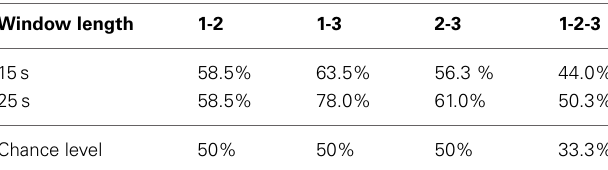
Table 2 | Classification accuracies of the conditions against each